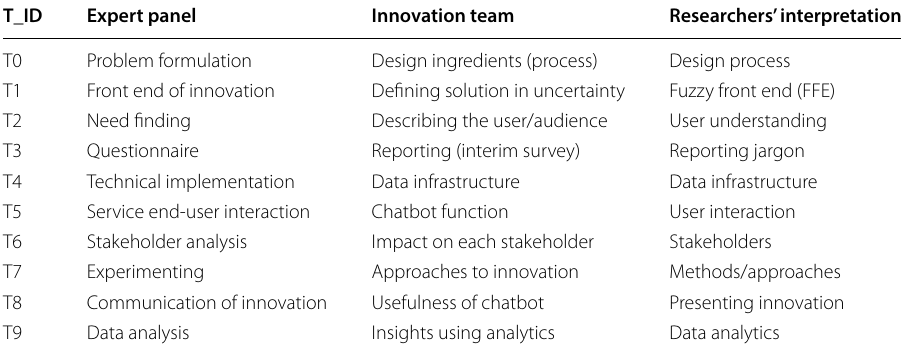
Table 10 Topics’ different codes based on multiple